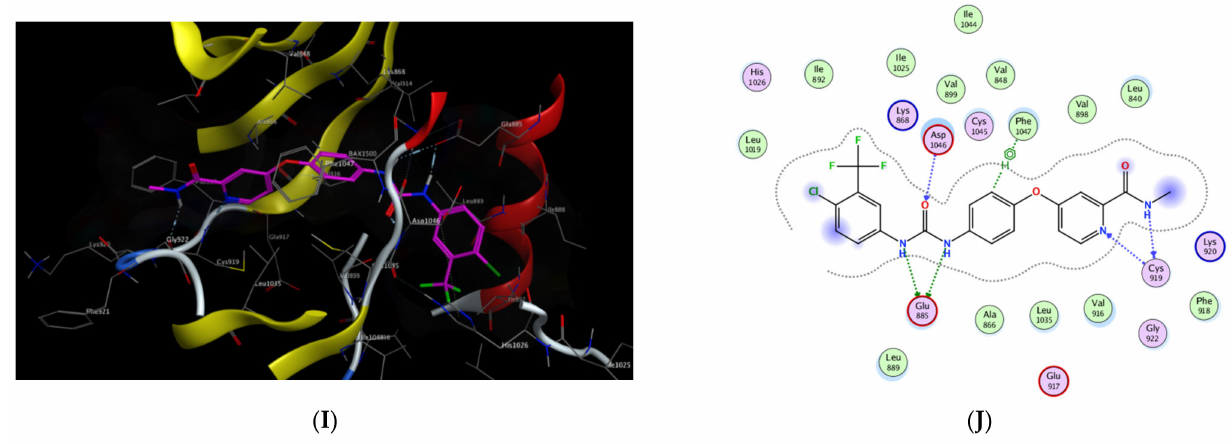
Figure 4. ( A ) The 3D binding mode of 8A (yellow sticks), ( B ) 2D binding mode of 8A , ( C ) 3D binding mode of 8B (green sticks), ( D ) 2D binding mode of 8B , ( E ) 3D binding mode of 9A (pink sticks), ( F ) 2D binding mode of 9A , ( G ) 3D binding mode of 9B (cyan sticks), ( H ) 2D binding mode of 9B , ( I ) 3D binding mode of sorafenib (magenta sticks), and ( J ) 2D binding mode of sorafenib in the active site of VEGFR-2 (PDB ID: 4ASD